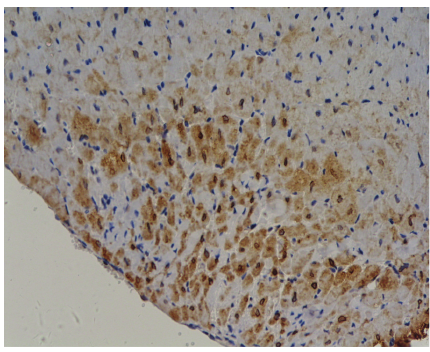
Figure 3: Baicalin-treated group-3h Bax × 200 (positive expres-